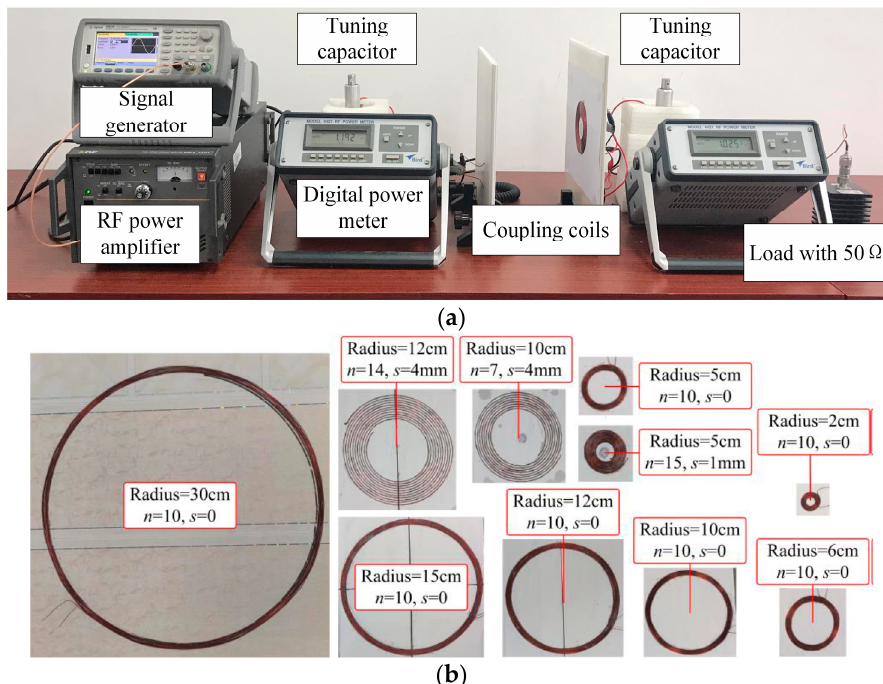
Figure 16. ( a ) Experimental platform; ( b ) coils with different parameters.